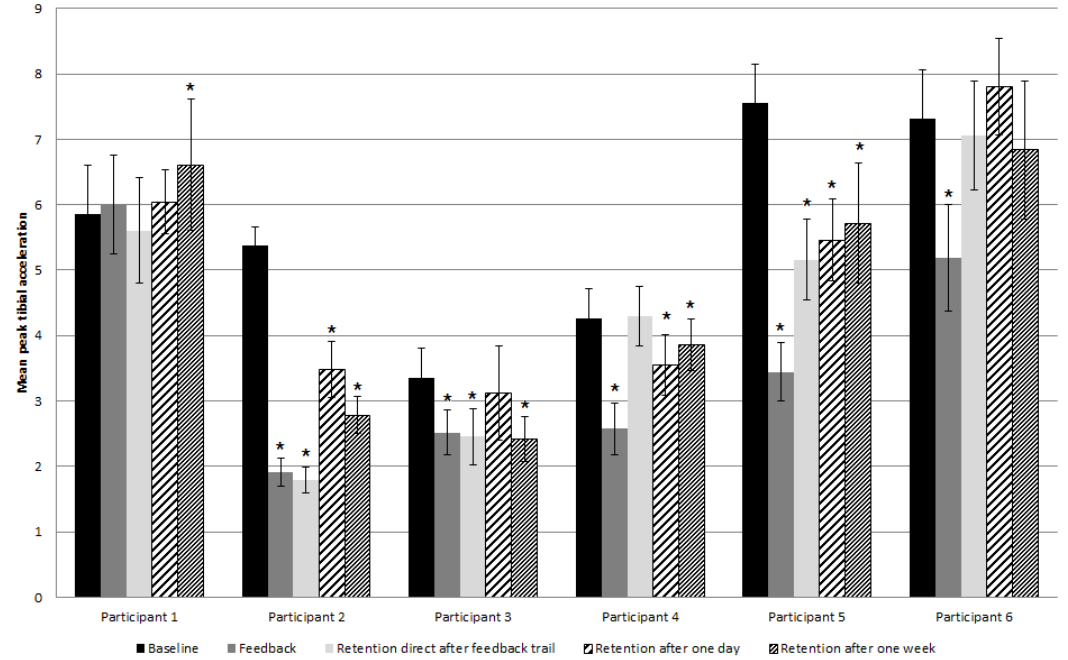
Figure 3. Mean peak tibial acceleration for the final 20 steps for each condition of each participant. The error bars display one SD.* indicates a significant difference for that condition compared to the baseline